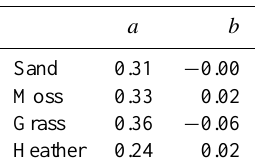
Table 2. Calibrated net emissivity parameters of the FAO-56 R nl submodel (Eq. 7).